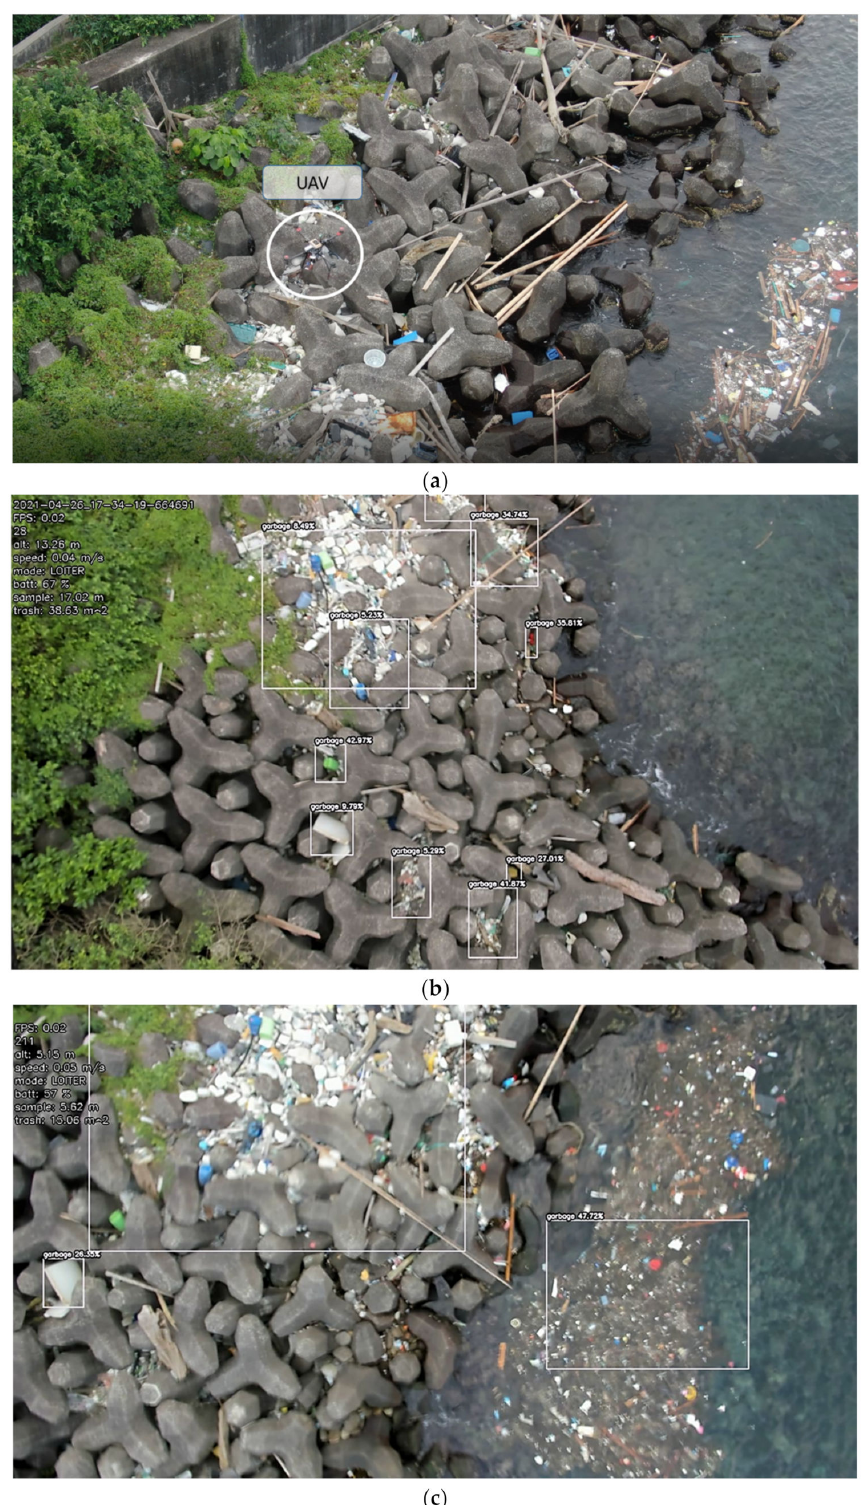
Figure 14. The result of the unmanned aerial vehicle (UAV) trash detection at the Badouzi fishing port. ( a ) The UAV in Badouzi fishing port at 10 m height. ( b ) Video streaming server: the detection result (a small area) in the Badouzi fishing port. ( c ) Video streaming server: the detection result (a large area) in the Badouzi fishing